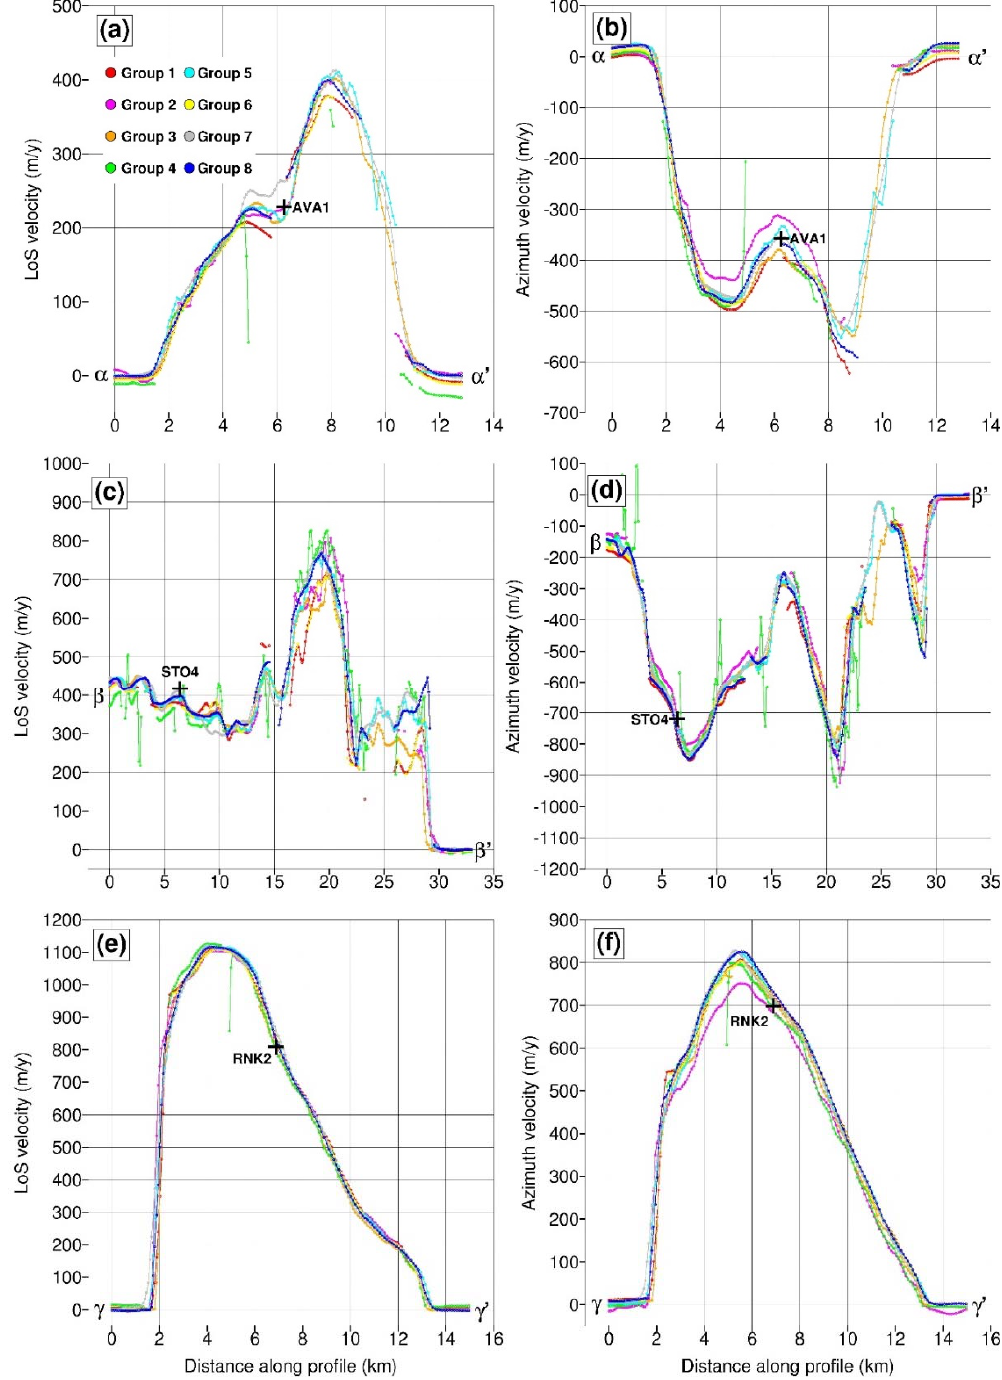
Figure 24. Task 4 LoS ( a , c , e ) and azimuth ( b , d , f ) velocity profiles for groups 1–8 along the dashed lines shown in Figures 18, 19, 21 and 22. Crosses represent the projected GPS velocity components.